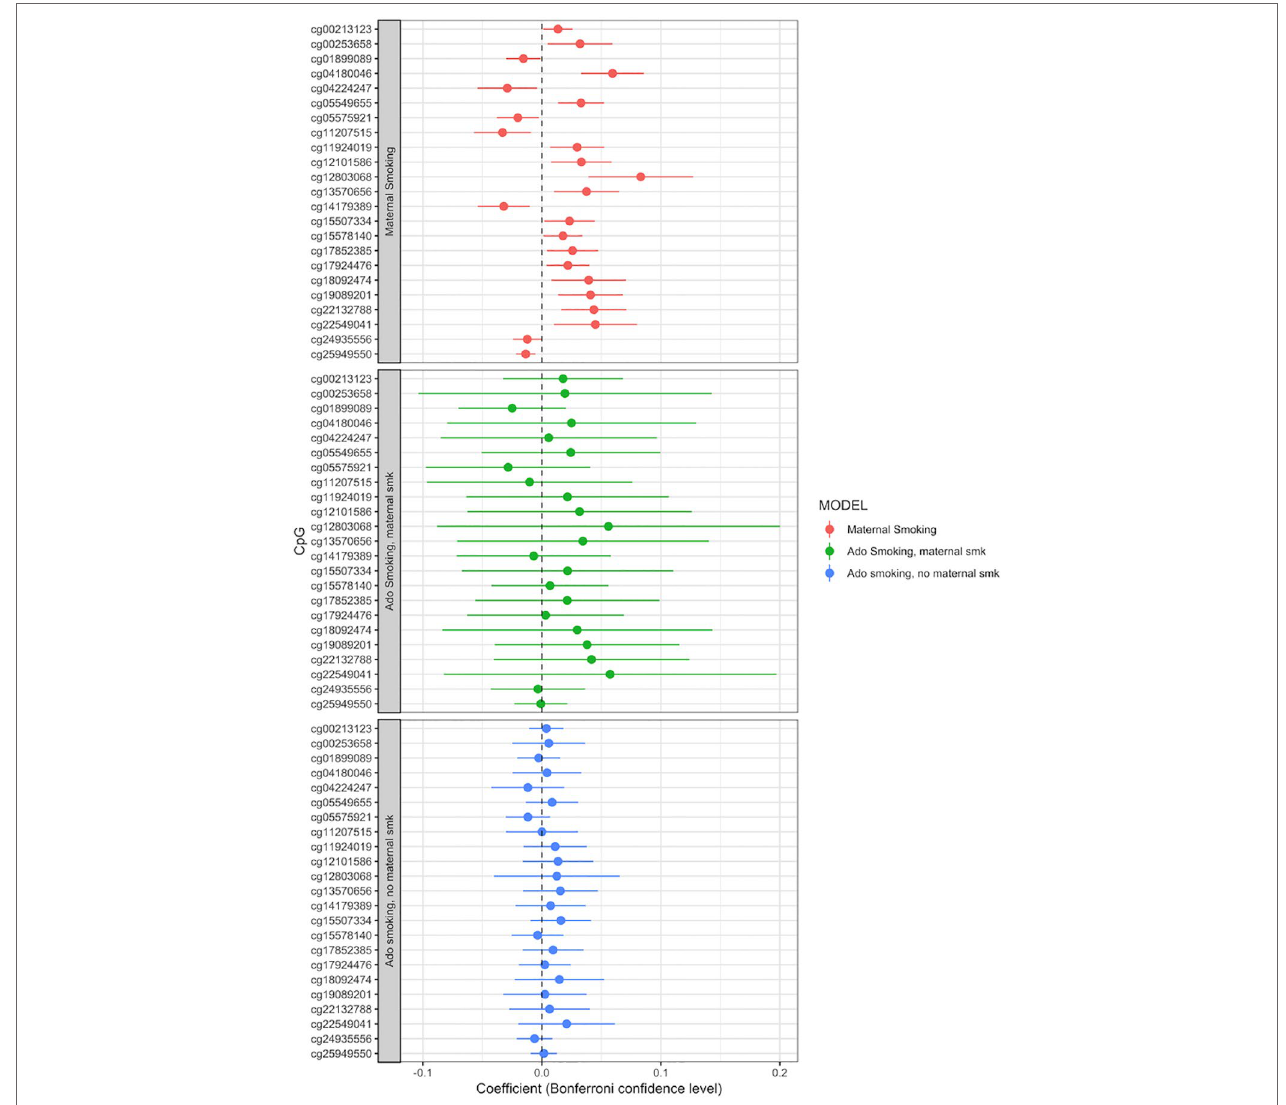
FIGURE 3 | Adolescent smoking, stratified by exposure to maternal smoking during pregnancy, and compared to the effect of maternal smoking during pregnancy (maternal smoking n = 790, adolescent smoking, maternal smoking n = 168, adolescent smoking, no maternal smoking n = 495). Models adjusted for sex, offspring age, age of the mother, birthweight, gestational weight gain, maternal alcohol consumption during pregnancy, maternal school level, maternal prepregnancy BMI, family income during pregnancy, cell count, and batch effects. X-axis : effect size from the linear mixed effects model and confidence interval; Y-axis : individual